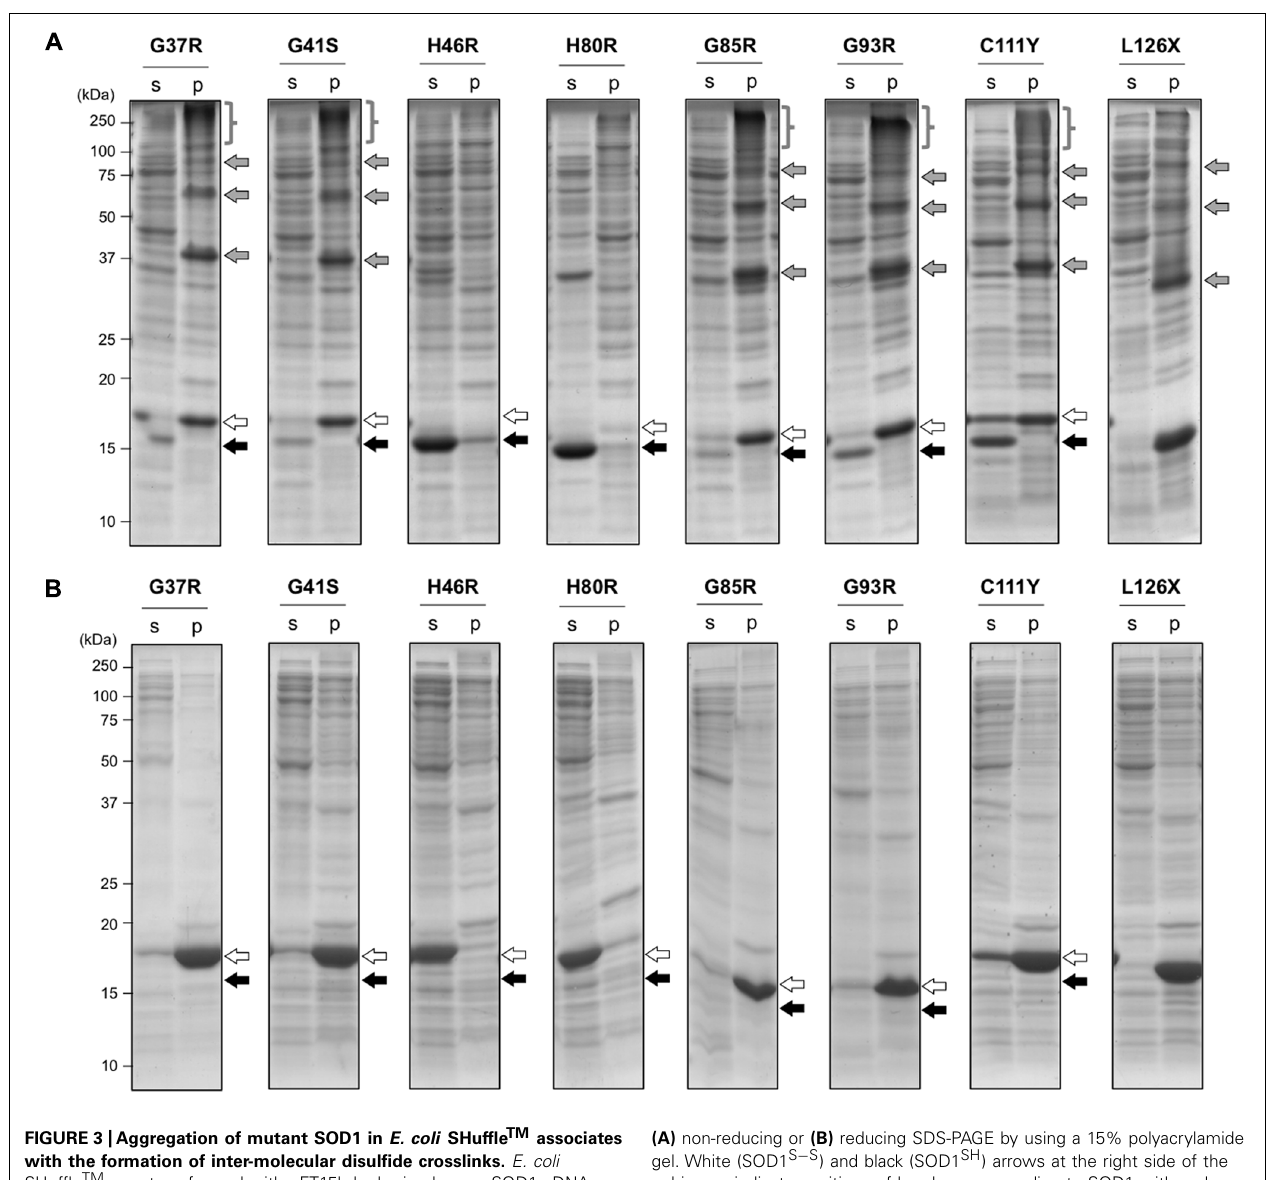
(A) non-reducing or (B) reducing SDS-PAGE by using a 15% polyacrylamide gel. White (SOD1 S − S ) and black (SOD1 SH ) arrows at the right side of the gel image indicate positions of bands corresponding to SOD1 with and without a disulfide bond, respectively. In addition, gray arrows and braces in (A) represent the disulfide-linked SOD1 oligomers, which disappeared in reducing SDS-PAGE (B)